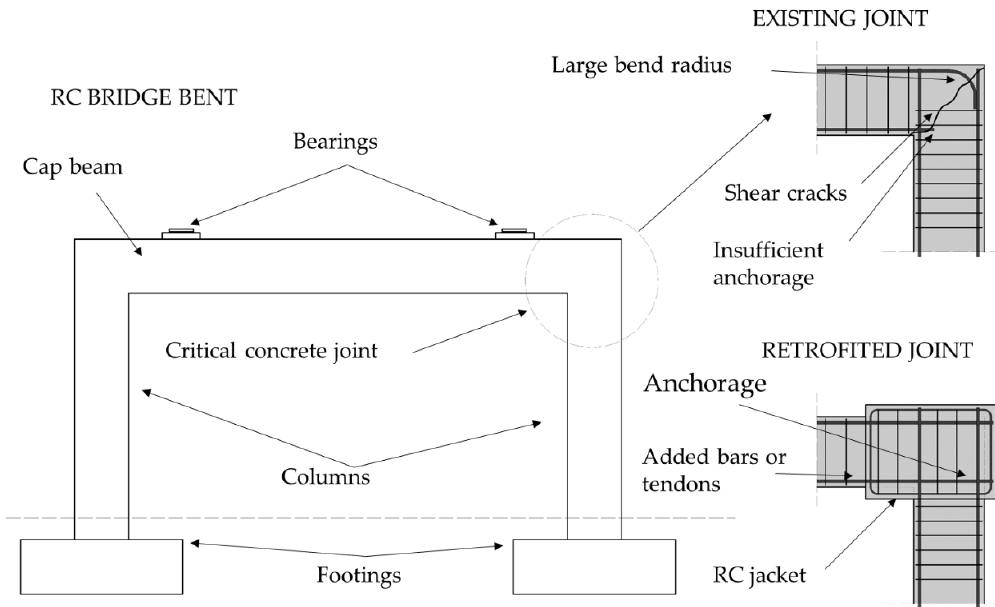
Figure 4. Seismic retrofitting of cap beams and concrete joints in RC bridge bents.